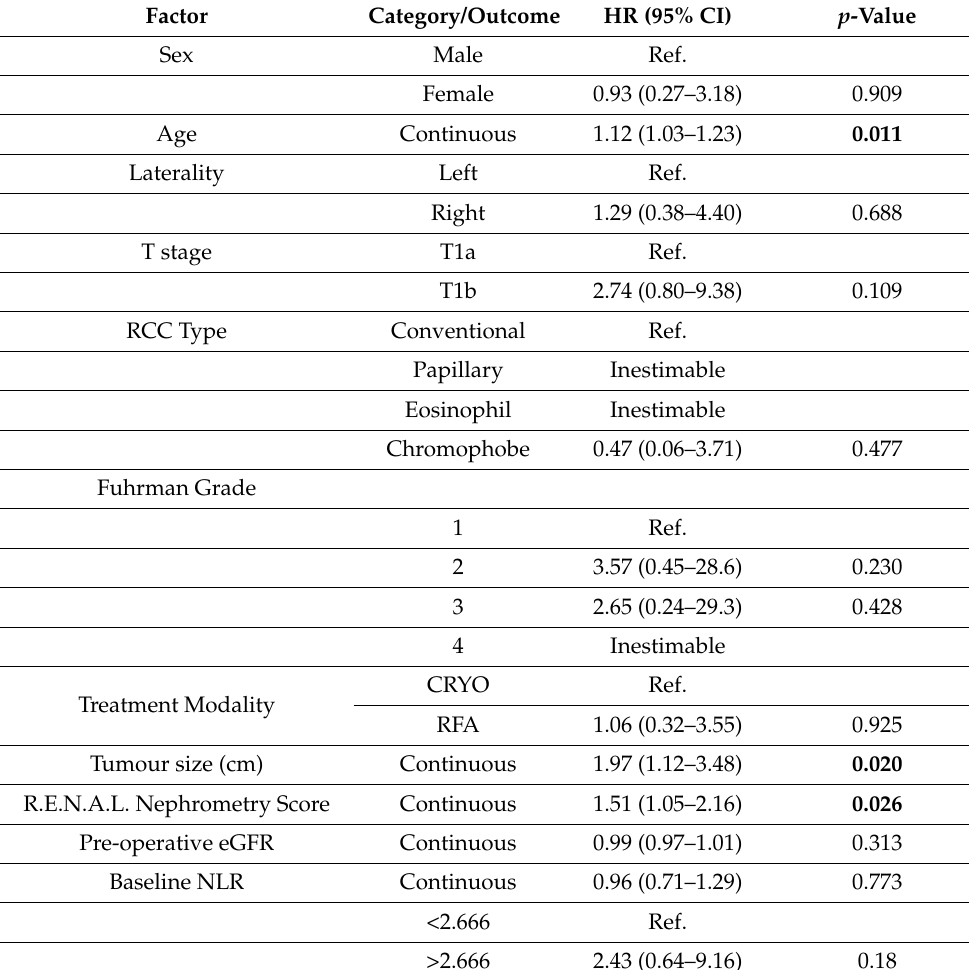
Table 5. Univariable analysis of prognostic factors associated with local-recurrence free